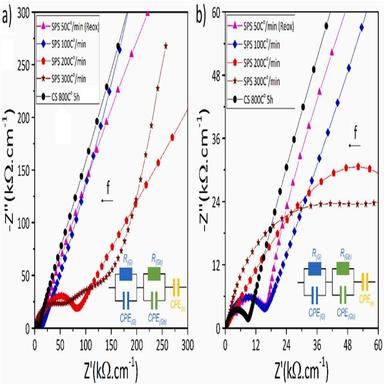
Impedance data recorded at 25◦C for LATP samples sintered, either 5 min by SPS at heating rates of 50 ◦C/min after reoxidation, 100 ◦C/min and 200 ◦C/ min, or by conventional method at 800◦C (5 h) (a). Enlargements are given from 0 to 60 kΩ.cm to better observe changes at high frequencies for the different samples (b). The complex impedance data shown here have been normalized regarding the shape factor of each sample for comparison purposes. The equivalent circuit used to fit the impedance data including a